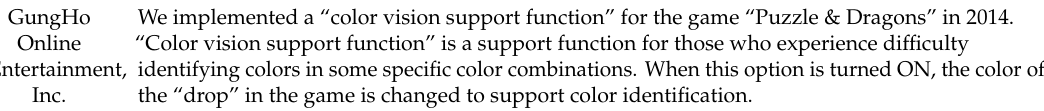
Table 4. List of games for people with disabilities by each company (Japan survey results).